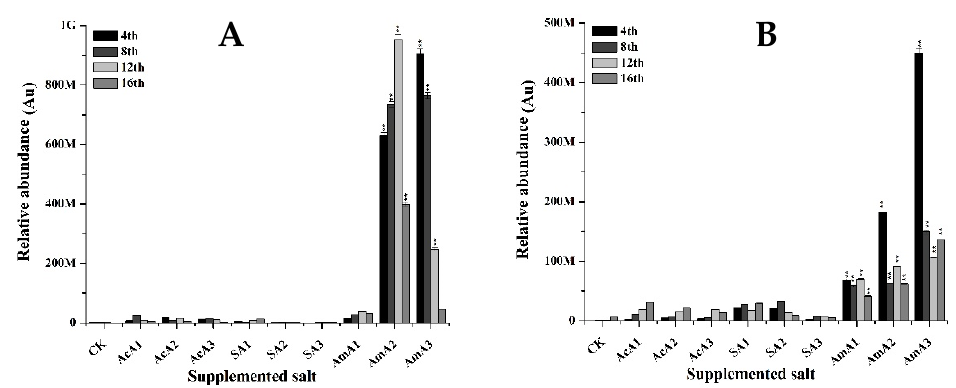
Figure 7. Rubropunctamine value of M. ruber M7 grown over PDA spiked with acetic acid, sodium acetate and ammonium acetate at different concentrations. Acetic acid: AcA1: 0.1%, AcA2: 0.25%, AcA3: 0.5%; Sodium acetate: SA1: 0.1%, SA2: 0.25%, SA3: 0.5%; Ammonium acetate: AmA1: 0.1%, AmA2: 0.25%, AmA3: 0.5%; CK: Controlled Kinetics. Error bars show the standard deviation among